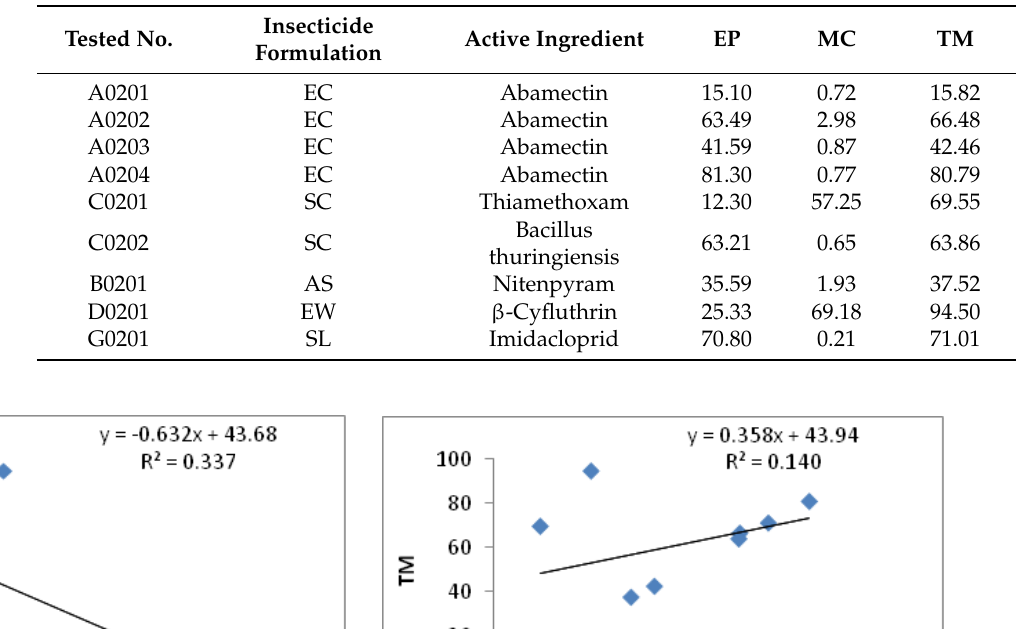
Table 3. MC, TM and EP of tested insecticides (%).